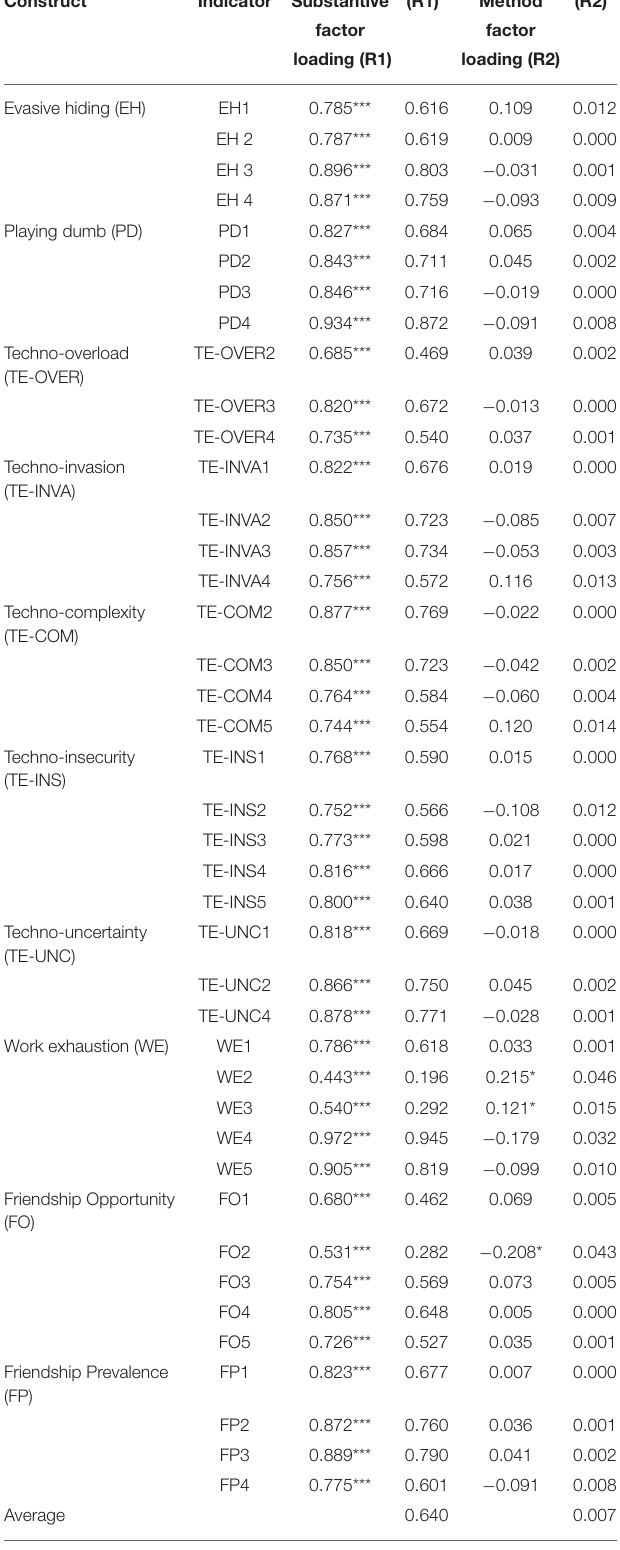
TABLE 6 | Common method bias analysis ( N =